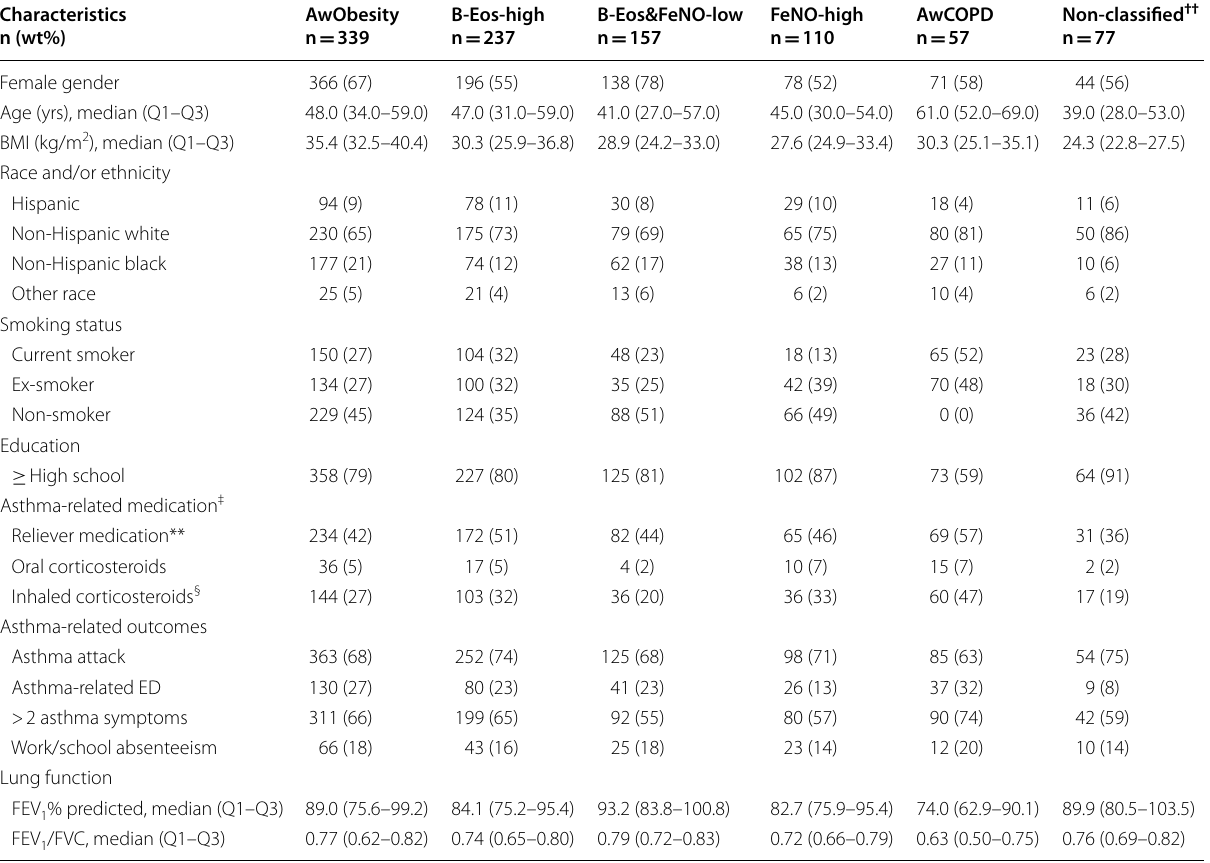
Data presented as absolute numbers and proportions weighted for the U.S.